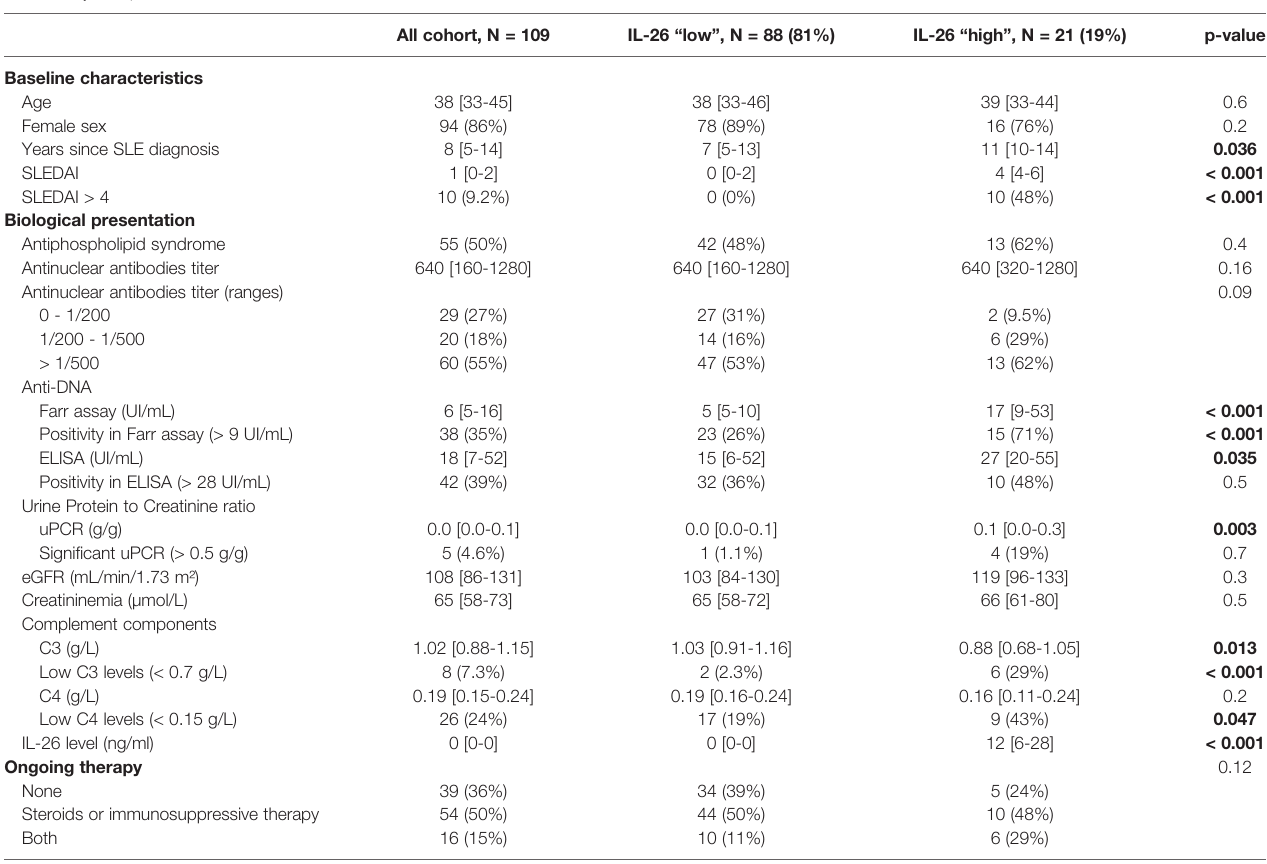
TABLE 1 | SLE patient